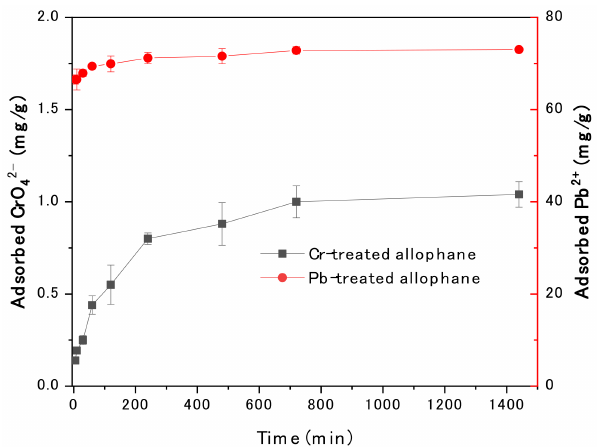
Figure 4. Effects of contact time on the adsorption of Pb 2+ and CrO 42 − onto synthetic allophane (initial concentration of CrO 42 − and Pb 2+ were maintained at 10 and 200 mg/L, respectively; pH of CrO 42 − and Pb 2+ were maintained at 2 and 5, respectively; the dosage of the absorbent was 40